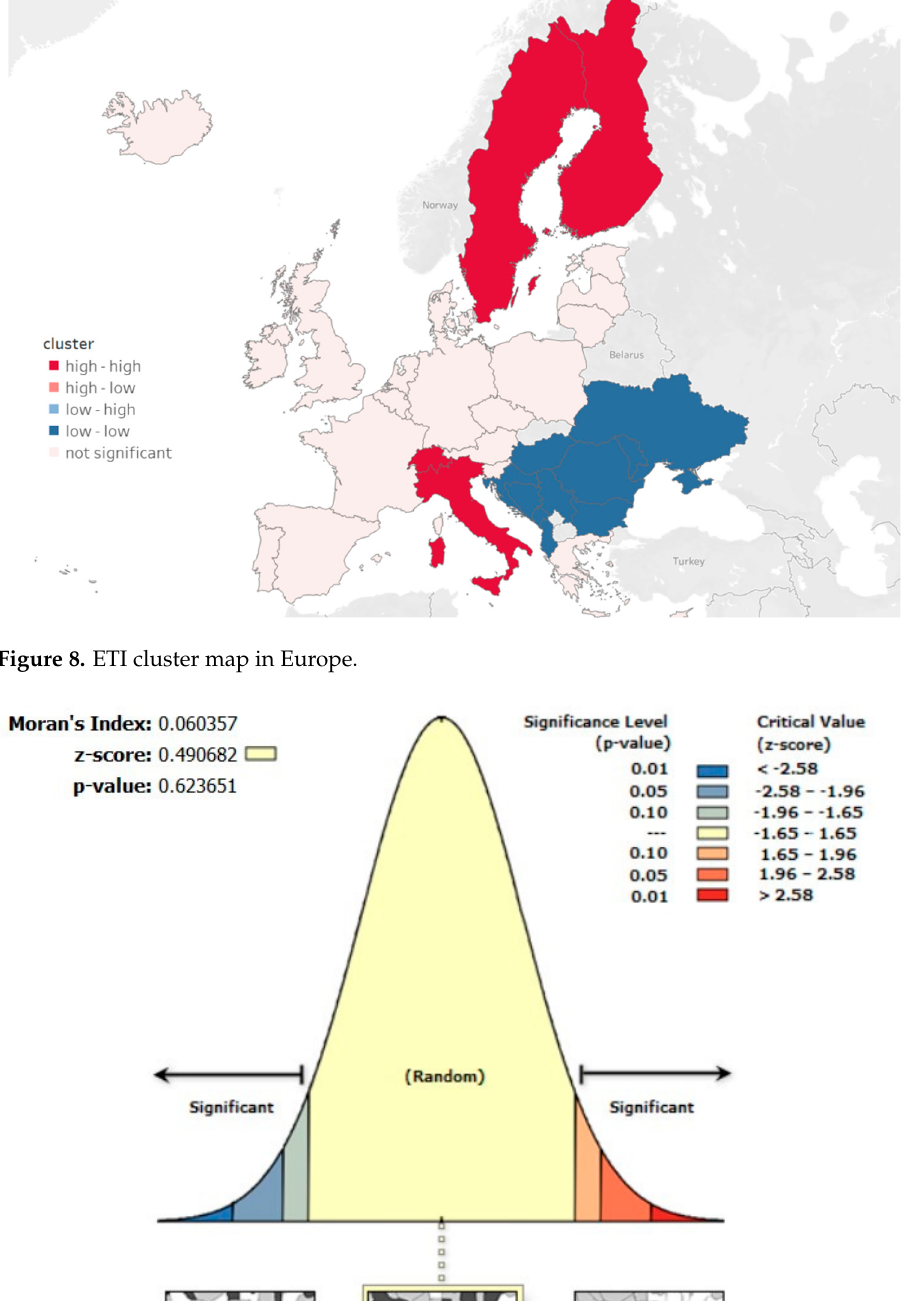
Figure 9. Moran’s I distribution for ETI in North and South America.